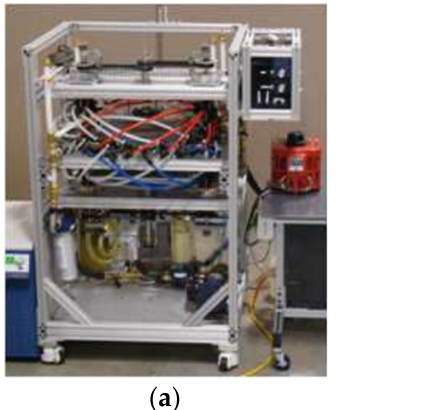
( b ) Figure 9. ( a ) Experimental device and ( b ) schema of the regenerator module [19,27]. Chaudron et al. (2016) [50] developed a rotary device with very high performances. Indeed, a temperature range of 20 K for a cooling power of 15 kW was generated. To